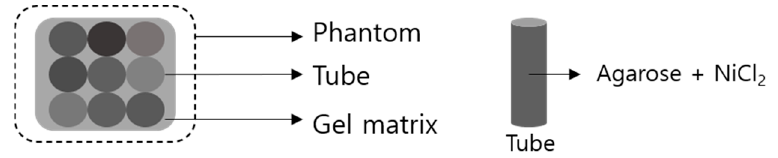
Figure 3. Phantom Composition for Cardiovascular MRI T1 Mapping Measurement. Phantoms are composed of a gel matrix that surrounds multiple tubes. Each tube is a mixture of agarose and NiCl 2 , and the T1 value can be created according to the situation or target needed to be measured by T1 values in the blood before and after the insertion of a contrast medium by changing the concentration of NiCl 2 .